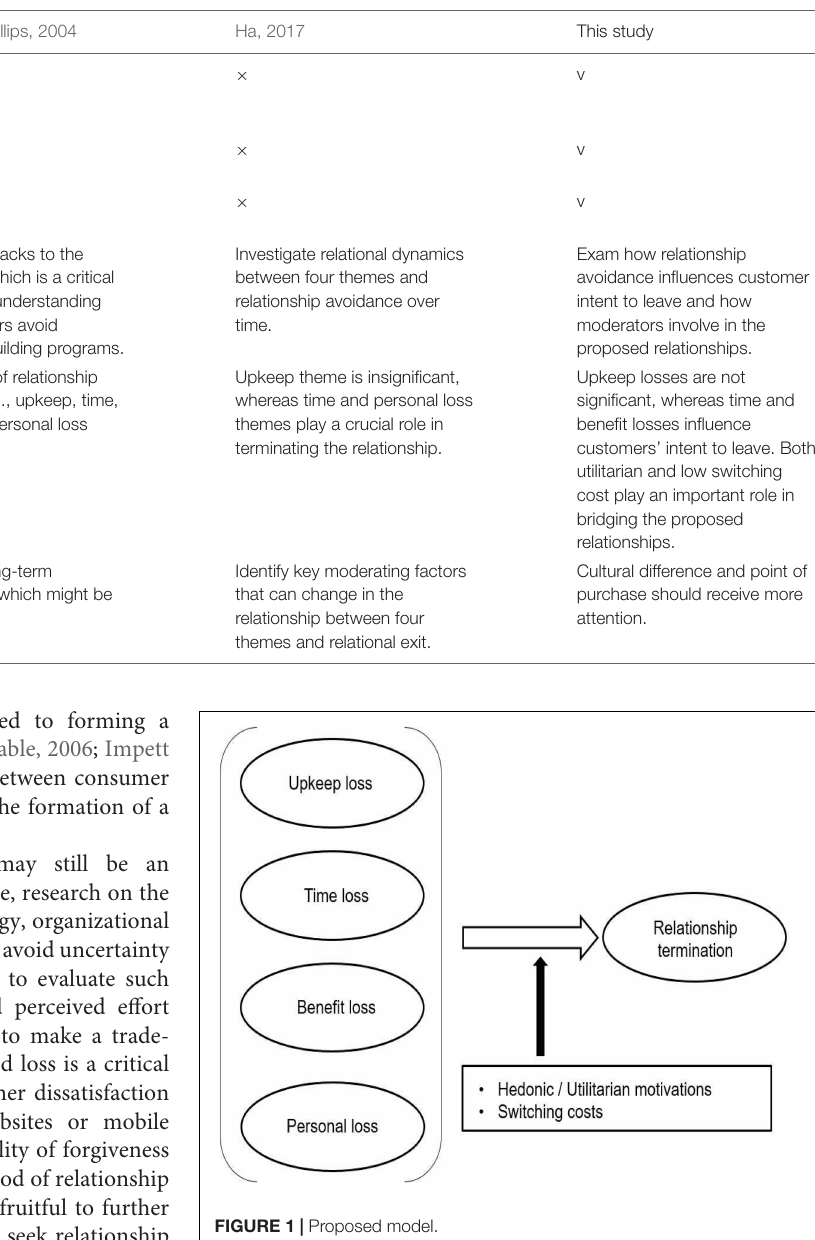
TABLE 2 | Studies that focus on four themes of relationship avoidance.